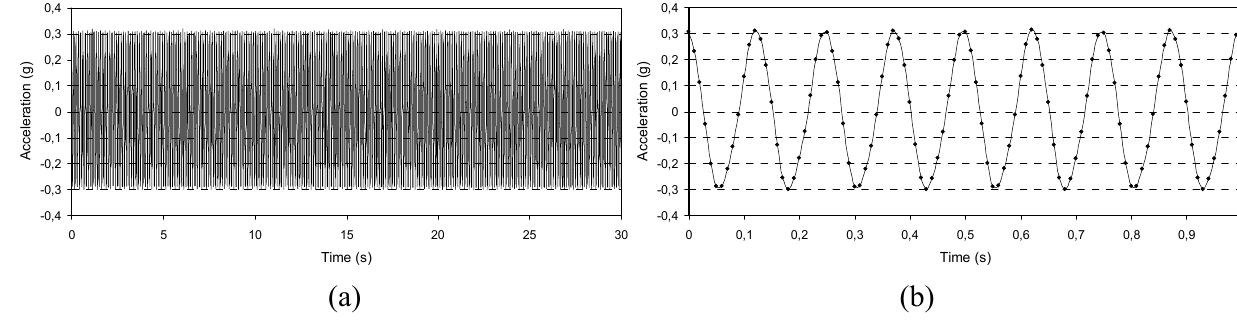
Figure 8. Low frequency characterization before dynamic excitation: 0.02 g amplitude, 1.5 Hz frequency, z-axis; whole acquisition (a) and detail of the wave form (b).